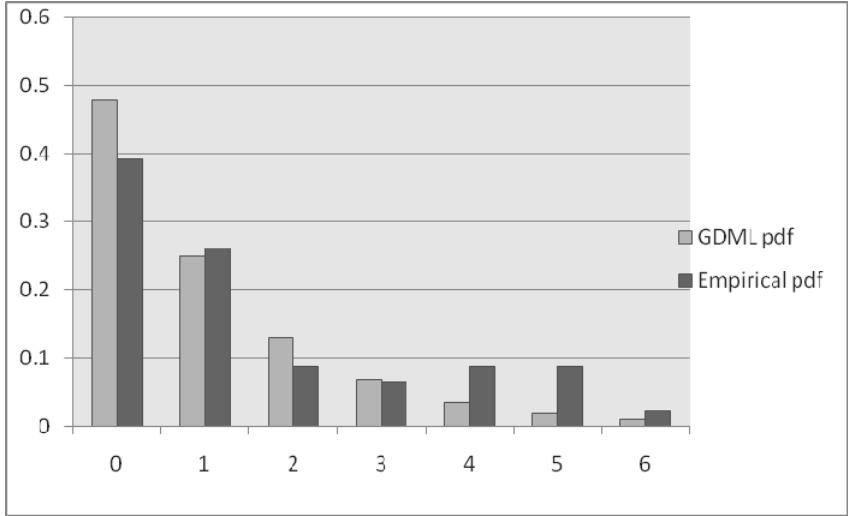
Figure 1 – The empirical pdf and theoretical pdf of GDML (0.99, 0.91, 1)